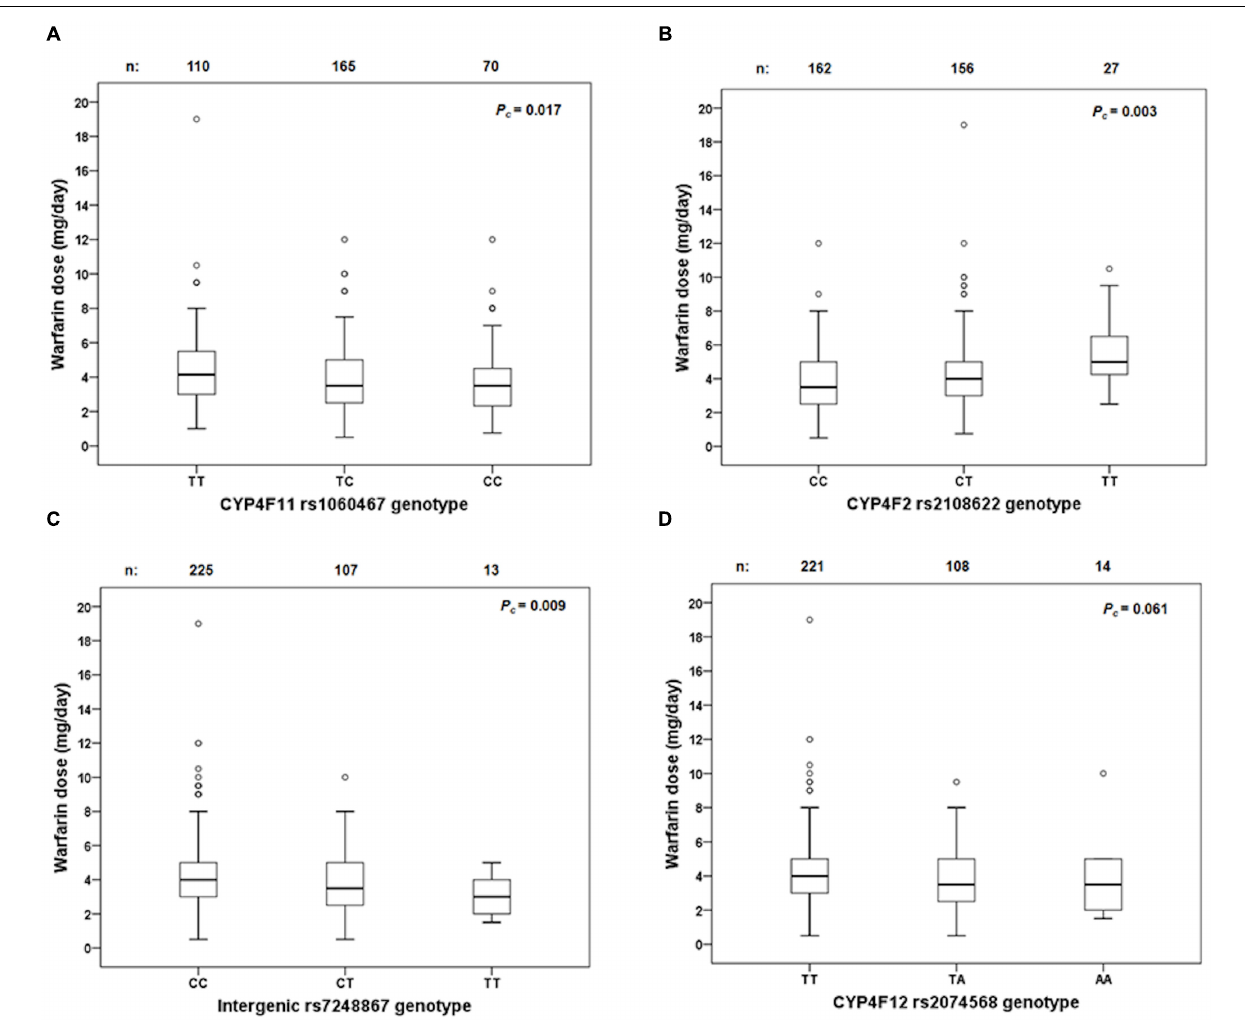
FIGURE 5 | Box and whisker plots showing the distribution of stable warfarin daily doses based on genotype groups in (A) CYP4F11 rs1060467; (B) CYP4F2 rs2108622; (C) intergenic rs7248867; (D) CYP4F12 rs2074568. Boxes represent 25th–75th percentiles of warfarin doses, whiskers represent 5th–95th percentiles, and solid lines represent median dose in each group. Open dots represent outliers. FDR-corrected P -values ( P c ) are shown on the upper right corner. Out of the 711 patients recruited prospectively, 345 achieved warfarin stable dose.